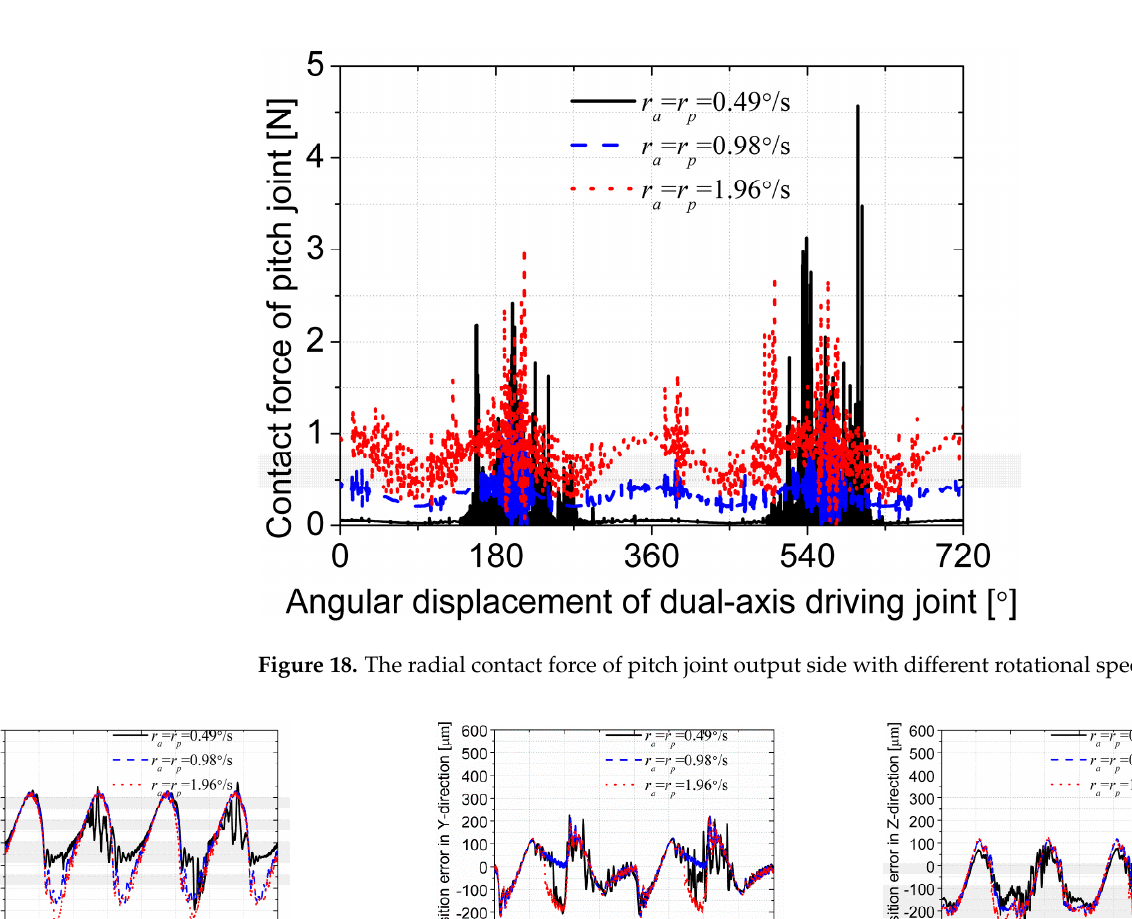
Figure 17. The radial contact force of azimuth joint output side with different rotational speeds.